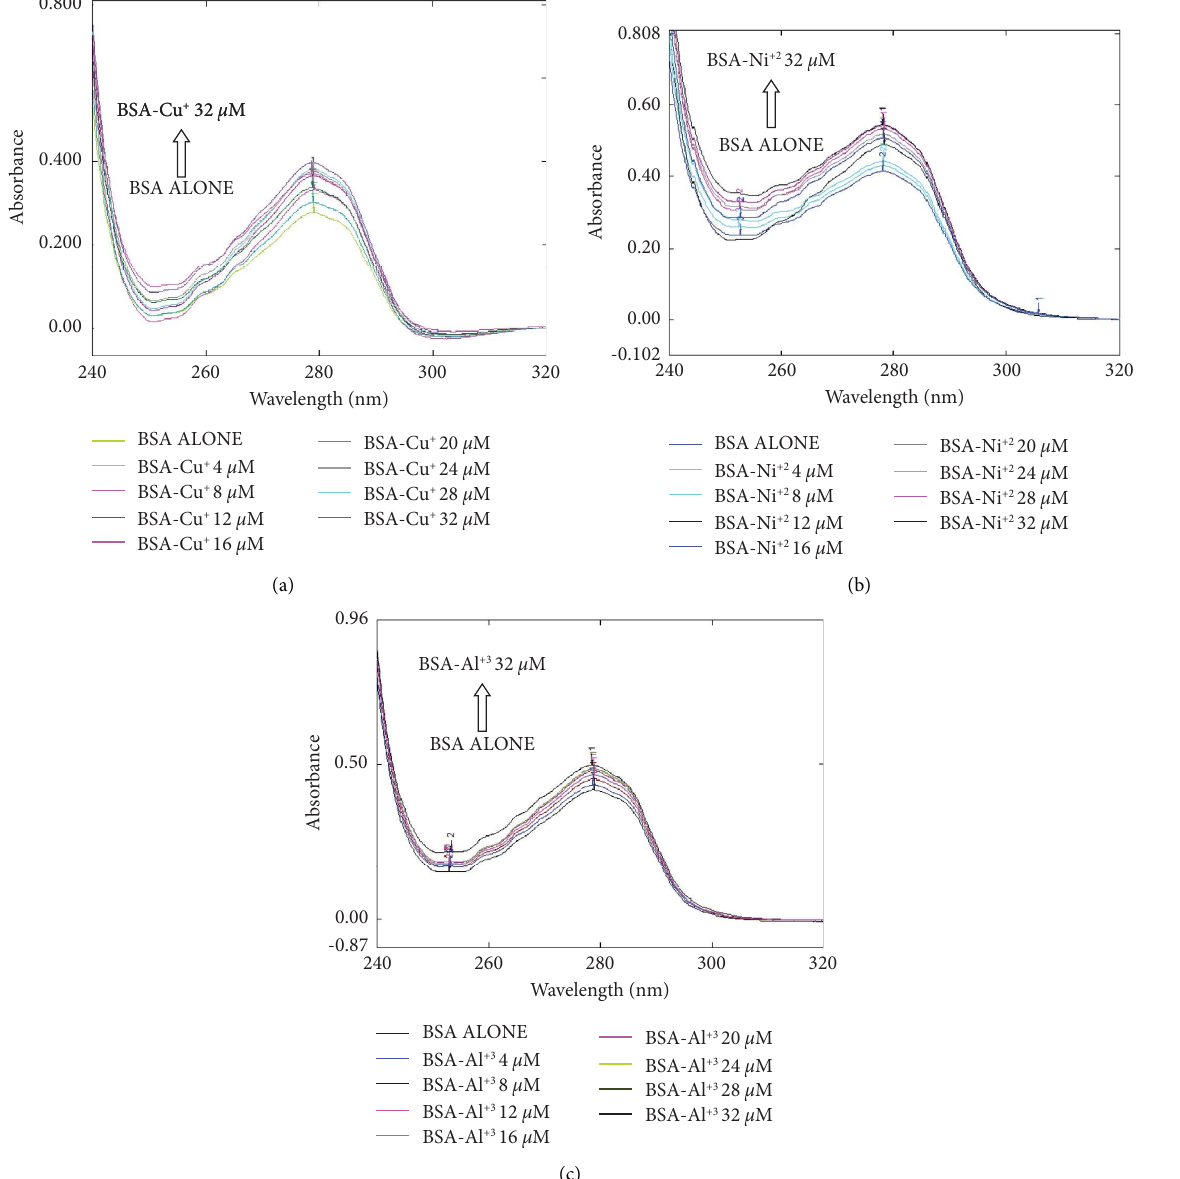
Figure 4: Spectral overlay showing increasing concentrations of (a) Cu + , (b) Ni +2 , and (c) Al +3 ions on BSA’s ability to absorb UV light; tris bufer; C BSA � 12 µ M; C metal � 0, 4, 8, 12, 16, 20, 24, 28, and 32 µ M (pH